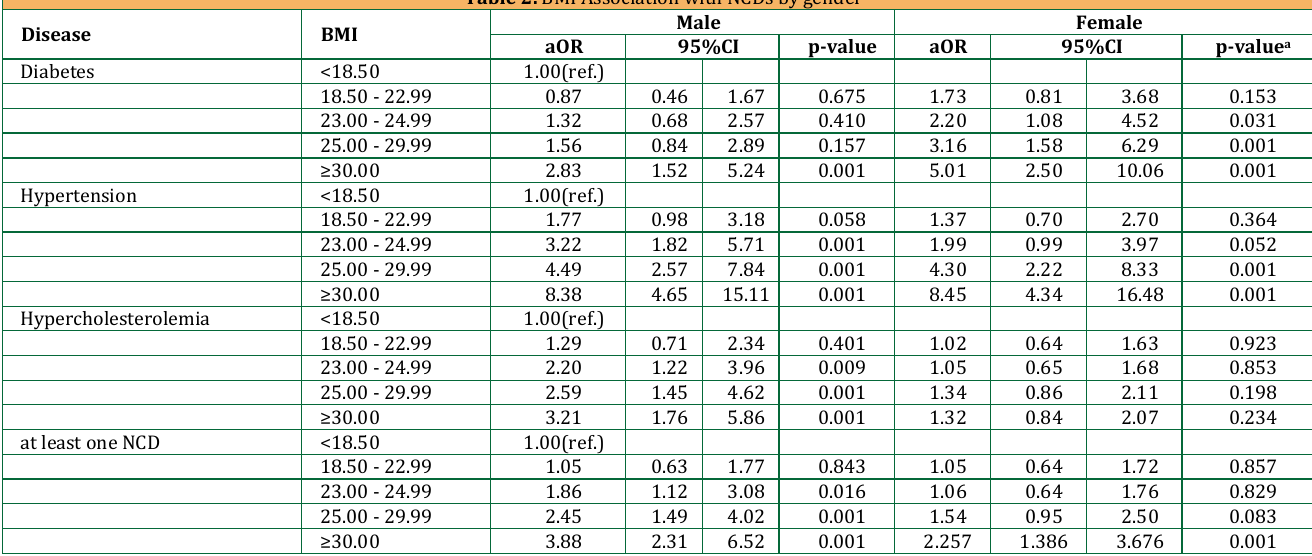
Table 2: BMI Association with NCDs by gender